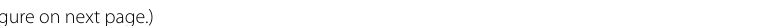
figure on next Fig. 5 Detiding of the Karachi marigram. a November 15 to December 1, 1945. Digitized version of traced marigram (black) is superimposed on tidal curve (light blue) approximated by piecewise fit of cubic polynomials to high waters and low waters—control points that were computed as in Fig. 5 for the days of the tsunami (November 28 and 29) and for two prior outages (November 20 and 23), and were fitted to the traced marigram outside those time windows. Graph of residual shows difference between these black and light blue curves. b As in a , but for November 27–29. c Previously detided curve for part of November 28 from Neetu et al. (2011, p